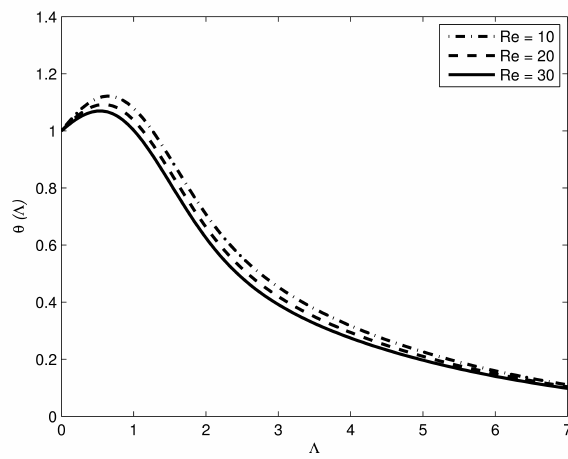
Figure 19: Effect of C 3 on θ ( Λ ) keeping ζ = 0.5 , η = 0.2 , C 1 = C 2 = 400 , Pr = 6.8 , Br = 1 , Re = 100